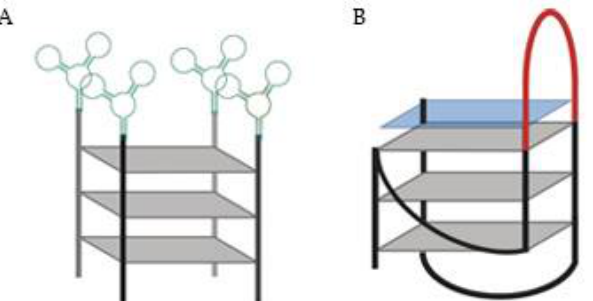
Figure 4. ( A ) DNA aptamer specific for Protein Tyrosine Kinase (PTK)7 (green) linked to 15 consecu- tive guanines, the AptG15 [56]. ( B ) G4-based drug delivery carriers (GDDC) loaded with an anionic copper(II) phthalocyanine (blue square).The GDDC presents a loop (red), which can hybridize with epidermal growth factor receptor mRNA